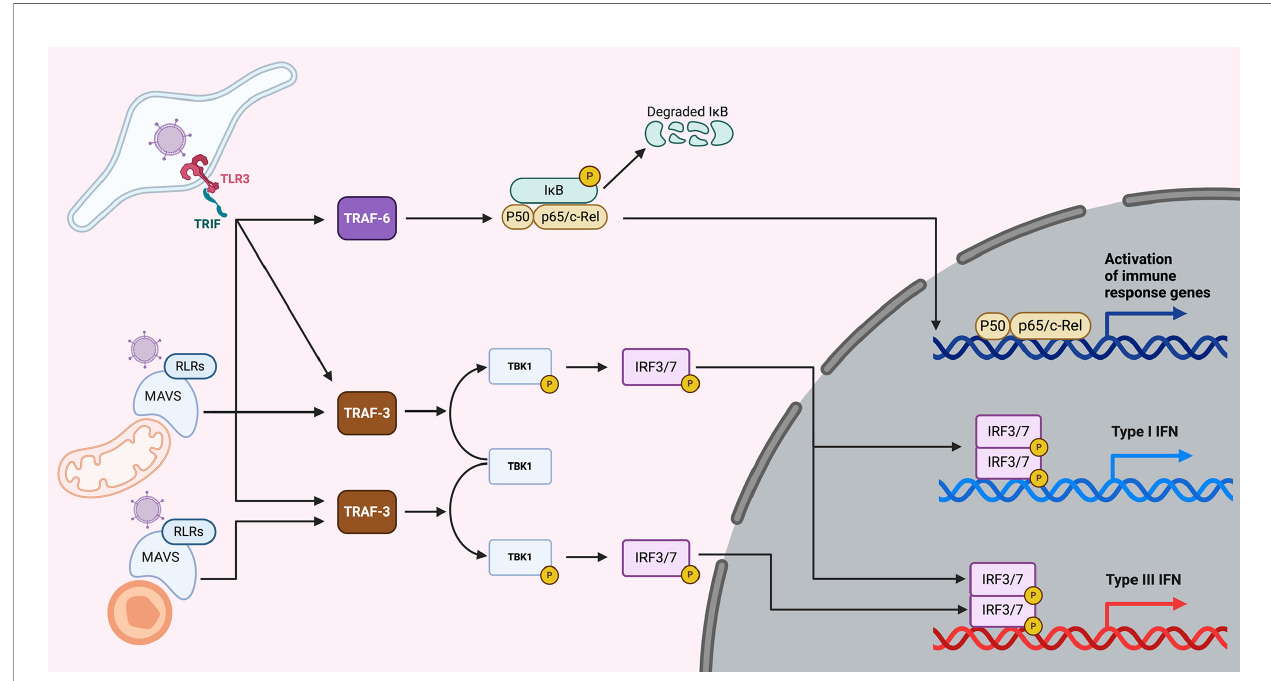
FIGURE 1 | Overview of IFN production upon viral infection. Upon virus entry into cells, viruses are sensed by the TLRs (endosomes) or the RLRs (cytoplasm). TLR3 senses dsRNA (a main component of viruses or viral replication) and is located in endosomes. Upon sensing of dsRNA molecules, TLR3 and its adapter TRIF lead to the induction of both the NF к B and the IRF3/7 pathways, which lead to the induction of both pro-in fl ammatory cytokines and type I and III IFNs. Viral PAMPs located in the cytosol are recognized by RLRs and upon activation recruit the adapter protein MAVS. When MAVS is recruited to mitochondria, NF к B and IRF3/7 are activated leading to the induction of pro-in fl ammatory cytokines and type I and III IFNs. However, when MAVS is recruited to peroxisomes the signaling cascade leads to the induction of type III IFNs